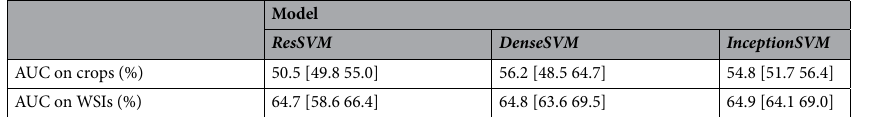
Table 3. Comparison of the median percentage AUC values achieved on both crops and entire WSIs by means of the three deep models, ResSVM, DenseSVM and